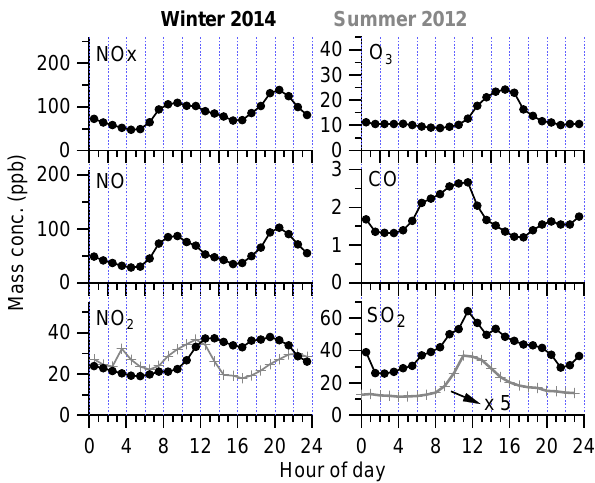
Figure 5. The diurnal variations of gas species downloaded from the MEP-China station during winter 2013/2014 and summer 2012.